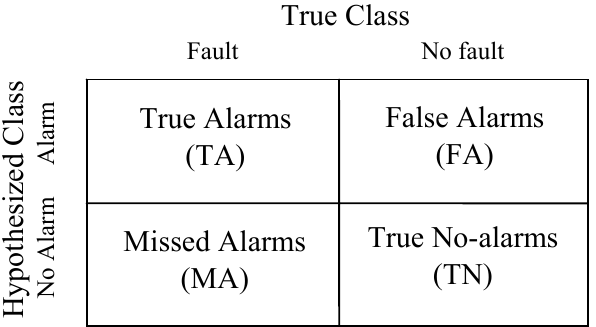
Figure 2. Confusion matrix to show the terminology of missed alarms and false